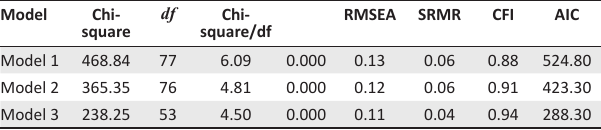
TABLE 2: Confirmatory factor analysis: Career embeddedness